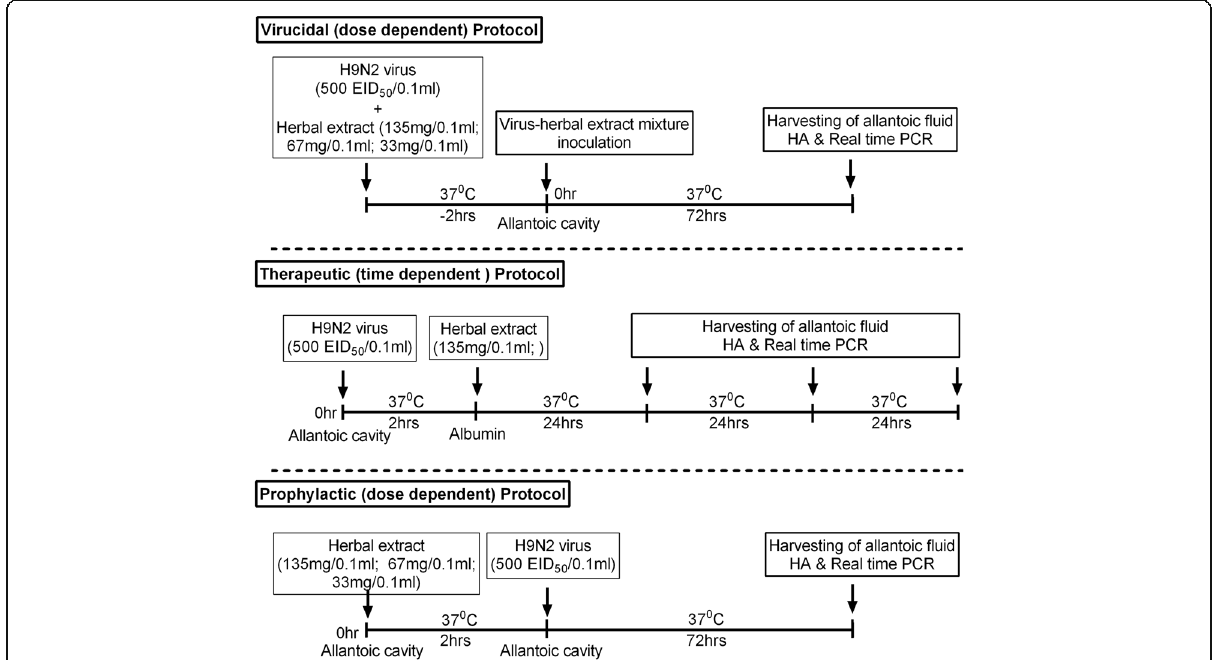
Fig. 1 Experimental protocols for the assessment of the antiviral activity of Ocimum sanctum and Acacia arabica leave extracts against H9N2 virus using in ovo